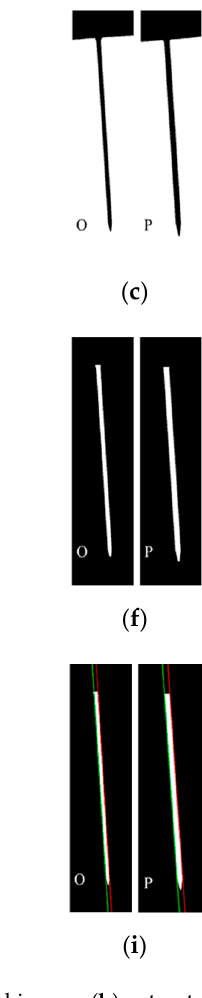
Figure 14. Comparison of the cutting blade detection algorithms. ( a ) Acquired image; ( b ) extracted ROI; ( c ) binary images; ( d ) background modeling images; ( e ) background removed images; ( f ) noise filtered images; ( g ) ROI detection images for tip restoration; ( h ) minimum rotated rectangular bounding box images; ( i ) line fitting images. Table 1. A performance comparison between the Otsu method and the proposed curvature-based binarization method for the cutting blade dimensions’